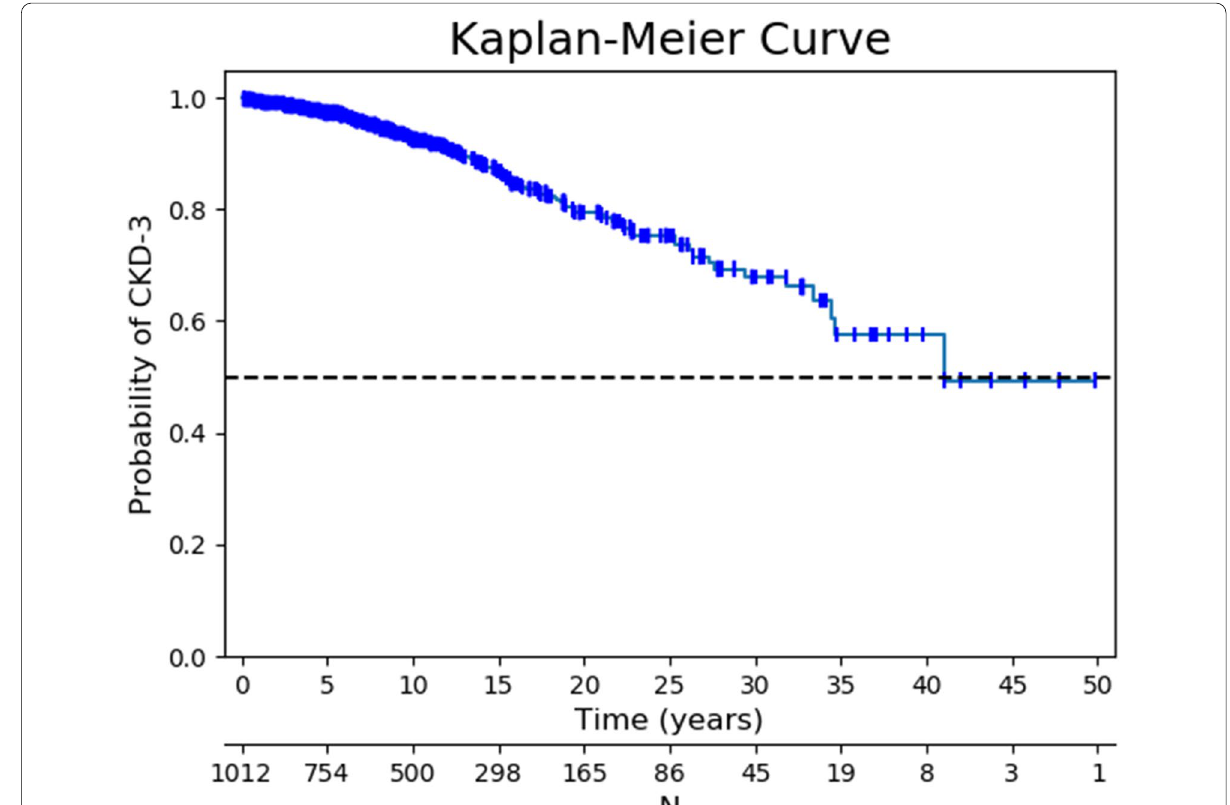
Fig. 1 Kaplan Meier curve of CKD-free survival in lithium treated